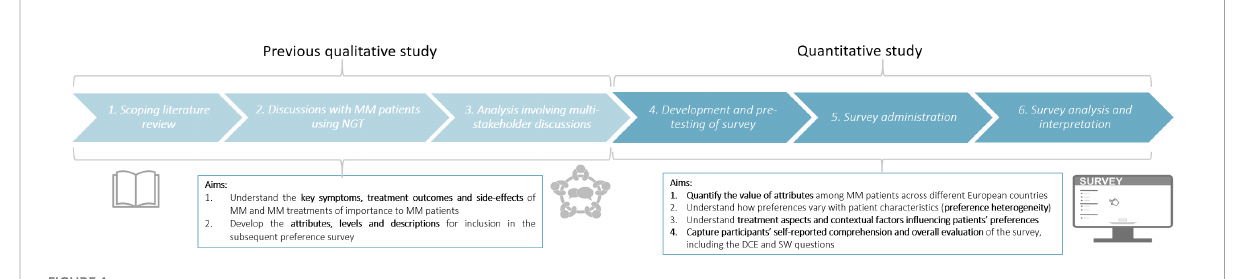
FIGURE 1 Design of the patient preference study, consisting of a qualitative and quantitative phase. The quantitative phase (reported in this paper) used the attributes, levels and descriptions that were identi fi ed in the previous qualitative study (13). The quantitative study consisted of the following three stages: i) development and pre-testing of the survey, ii) survey administration, and iii) survey analysis and